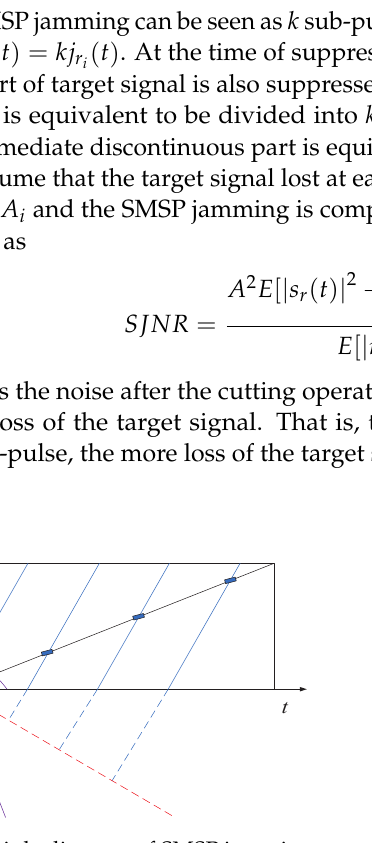
Figure 5. Principle diagram of SMSP jamming suppression in the time-frequency